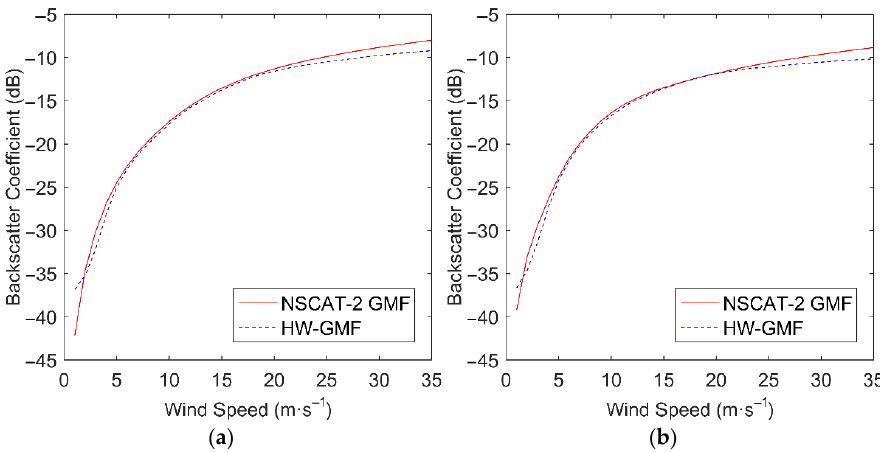
Figure 5. Mean backscatter coefficient curves of HW-GMF and NSCAT-2 GMF; the red solid line corresponds to NSCAT-2 GMF, and the blue dashed line corresponds to HW-GMF. ( a ) HH polarization. ( b ) VV polarization.